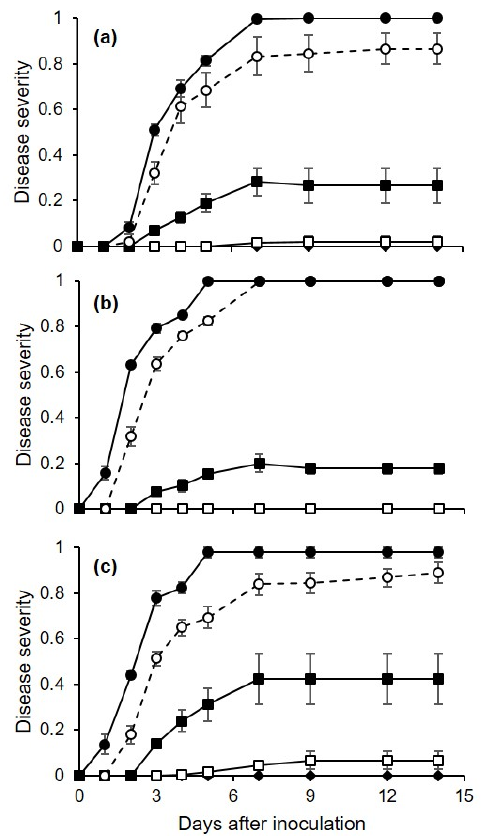
Figure 4. Progress of disease severity (as the proportion of berry surface showing symptoms, on a 0–1 scale, where 1 means that all of the berry surface is affected) on grapevine berries that were injured and then drop-inoculated with a suspension of Coniella diplodiella that contained 10 (black diamond), 10 2 (white squares), 10 3 (black squares), 10 4 (white circles), or 10 5 (black circles) conidia/mL (experiment 2). After inoculation, berries were incubated for a 24 h wet period at 15 ( a ), 25 ( b ), or 35 °C ( c ). Values are the means (± SE, n =